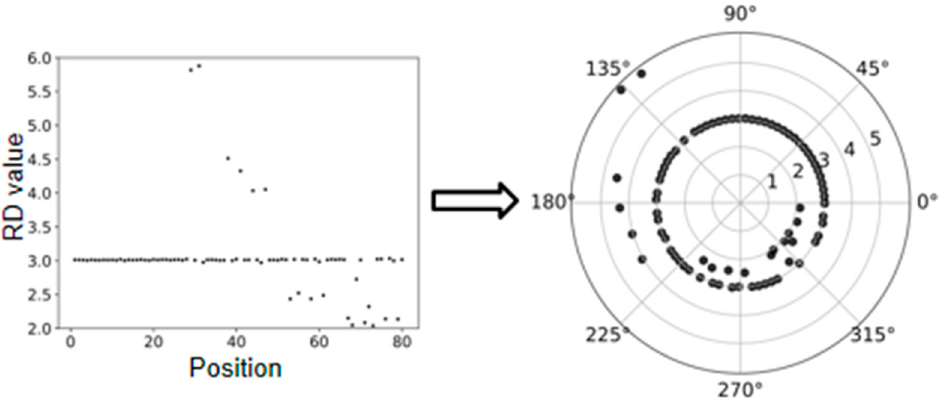
Figure 2. An example to show the polar coordinate transformation from a line-shaped RD profile to a circular-shaped RD profile. a circular-shaped RD